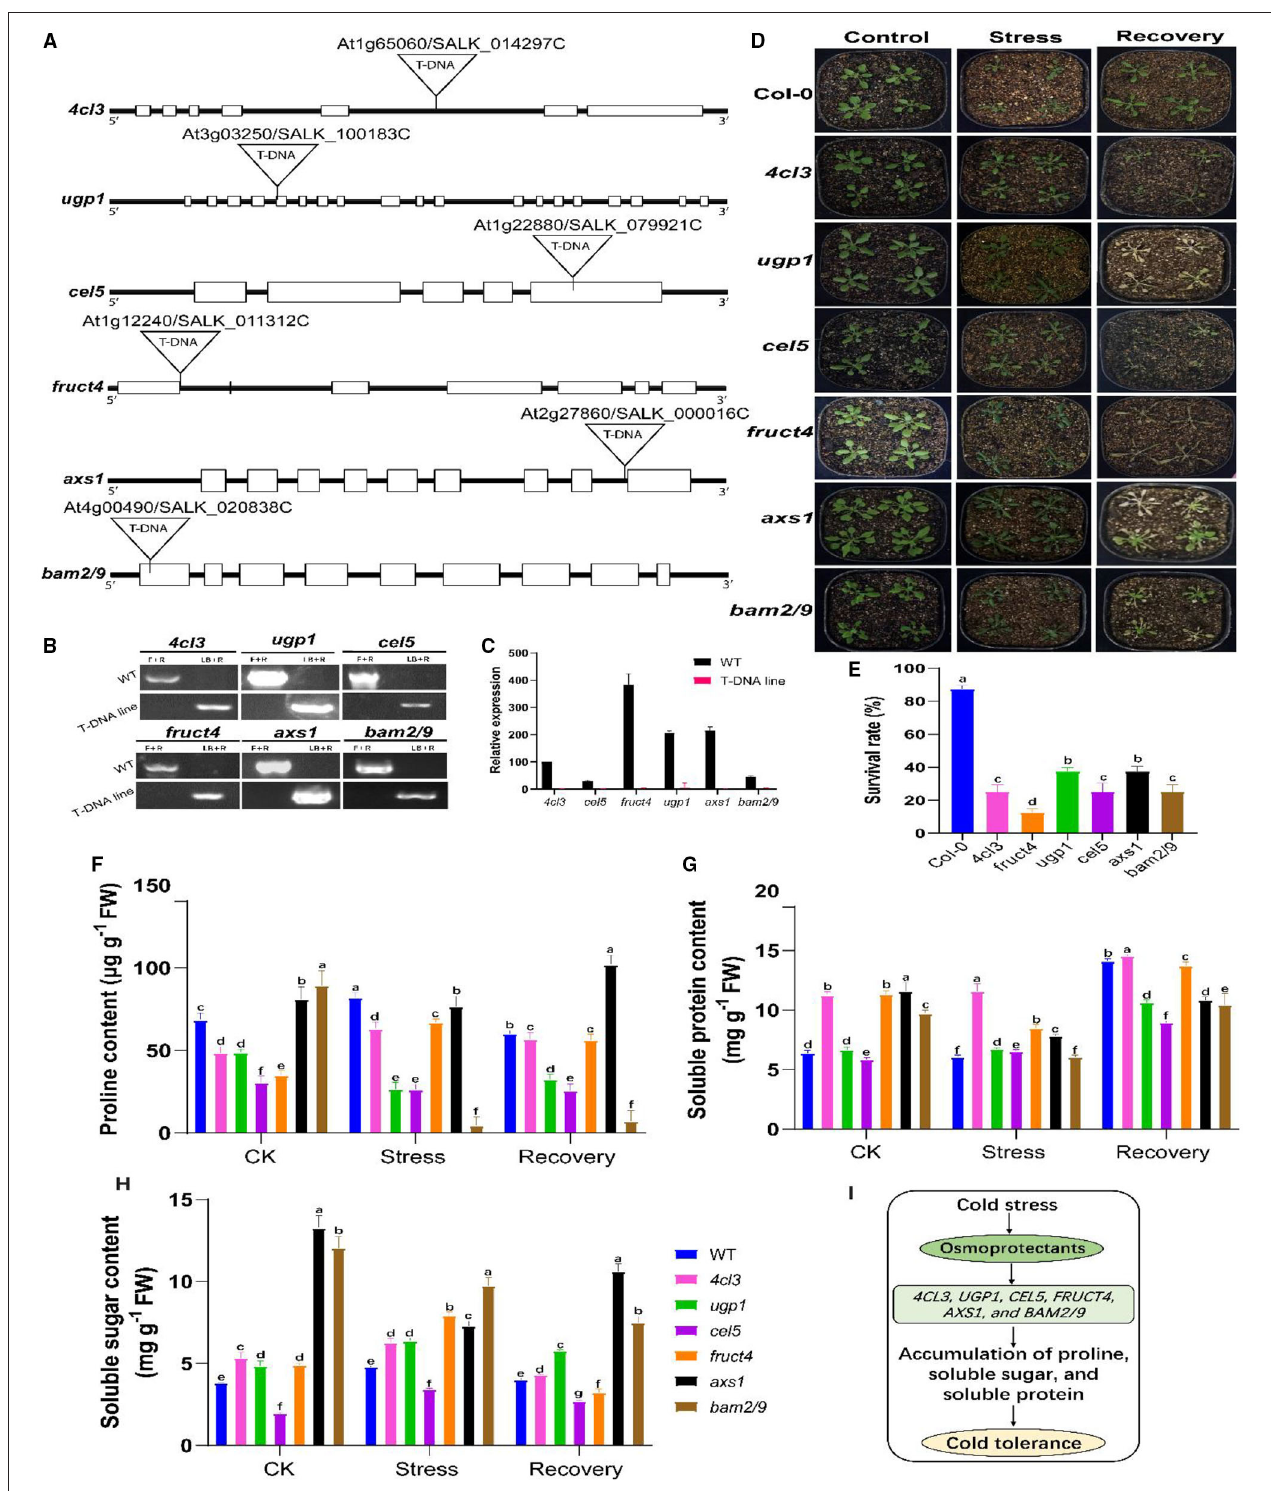
FIGURE 11 | Functional validation of selected candidate genes using Arabidopsis mutants. (A) Schematic diagram of the gene structure of 4cl3 (4-coumarate coenzyme A ligase 3), ugp1 (UDP-glucose pyrophosphorylase 1), cel5 (CELLULASE 5), fruct4 (beta-fructosidase 4), axs1 (UDP-D-xylose synthase 1/UDP-D-apiose), and bam2/9 (beta-amylase 2/9). Exons and introns are indicated in black boxes and black lines, respectively. (B) PCR-based genotyping of these mutants. (C)